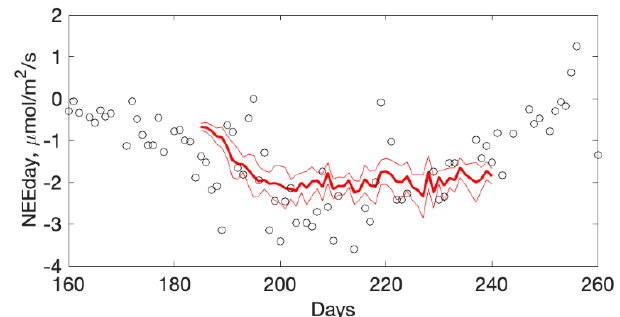
Figure 8. Comparison between the daytime averaged flux tower NEEday (black squares) and the estimated NEEday (weighted-average within the tower footprint) during the growing season. The thick red line represents the mean estimate, while the thin red lines represent the 99-percent confidence